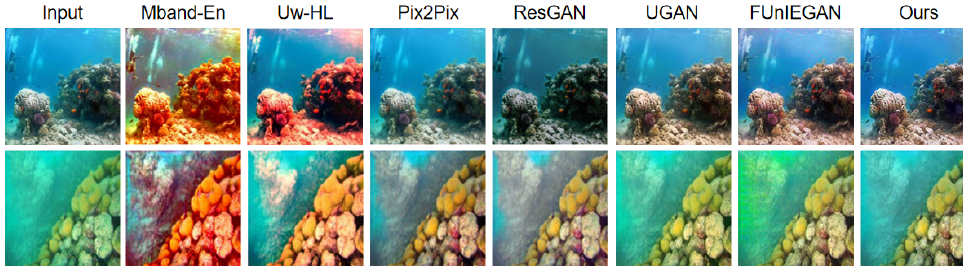
Figure 7. Comparison results with Mband-En, Uw-HL, Pix2Pix, ResGAN, UGAN, FUnIE-GAN on the EUVP dataset.